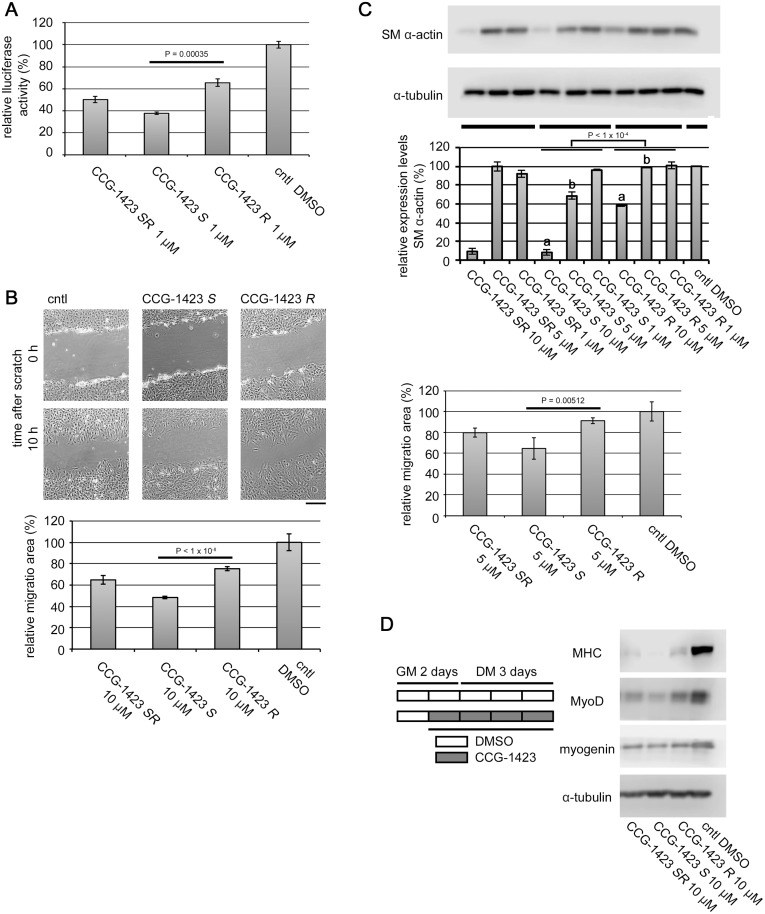
Effects of the racemic and chiral CCG-1423 on the cellular events mediated through MRTF-A/SRF.(A) Promoter analysis using SRF-dependent reporter gene. NIH3T3 cells were transfected with 500 ng of 3xCArG-Luciferase report plasmid, 200 ng of Flag-tagged MRTF-A expression plasmid, and 300 ng of pSVβ−gal. They were cultured for 48 h. For the last 24 h, they were treated with vehicle or 1 μM of racemic or chiral CCG-1423. The luciferase activity with vehicle only (control [cntl] DMSO) was set at 100%. Each value represents the means ± SEMs of results from three independent experiments. Statistical differences were calculated using student’s t-test. Significance levels were as follows: CCG-1423 SR vs CCG-1423 S, P = 0.00240; CCG-1423 SR vs CCG-1423 R, P = 0.01411; CCG-1423 S vs CCG-1423 R, P = 0.00035. (B) Wound healing assay. Confluent cultures of NIH3T3 cells were pre-treated with 10 μM of each of the respective compounds or vehicle for 20 h, and then they were scratch-wounded with a 20 μl pipette tip. Bar = 25 μm (upper panel). Cell migration was monitored and quantified as described in Materials and Methods (lower panel). Each value represents the means ± SEMs of results from three independent experiments. Statistical differences were calculated using student’s t-test. Significance levels were as follows: CCG-1423 SR vs CCG-1423 S, P < 1 × 10−4; CCG-1423 SR vs CCG-1423 R, P = 0.00143; CCG-1423 S vs CCG-1423 R, P < 1 × 10−8. High magnification images were shown in S1 Fig. (C) Effects on the expression of SM α−actin and cell motility of fibroblasts. Human skin fibroblasts were cultured as described in Materials and Methods. For the last 48 h (upper IB analysis) or 20 h (lower cell migration analysis), cells were treated with vehicle or the indicated concentrations of each of the racemic or chiral CCG-1423. Whole cell lysates were subjected to IB analysis with anti-SM α−actin-antibody (upper panels). α−tubulin was used as a loading control. Dose-dependent effects of the respective stereoisomers were analyzed using a two-way ANOVA. The dose-dependent effects between CCG-1423 S and CCG-1423 R were significantly different (P < 1 × 10−4). Significance levels between bar graphs with a and between bar graphs with b were as follows: aP < 1 × 10−4 and bP < 1 × 10−4. Cell migration was monitored and quantified as described above (lower panel). Each value represents the means ± SEMs of results from three independent experiments. Statistical differences were calculated using student’s t-test. Significance levels were as follows: CCG-1423 SR vs CCG-1423 S, P = 0.05748; CCG-1423 SR vs CCG-1423 R, P = 0.00834; CCG-1423 S vs CCG-1423 R, P = 0.00512. (D) Effect on the differentiation of skeletal myoblasts. C2C12 myoblasts were initially cultured in GM for 2 days, and then were cultured in DM for 3 days. The experimental processes were schematically shown in the left column. White and gray rectangles indicated the cultured period treated with vehicle or 10 μM of racemic or chiral CCG-1423, respectively. Whole cell lysates were prepared at DM 3 day, and they were subjected to IB analysis (right column). α−tubulin was used as a loading control.